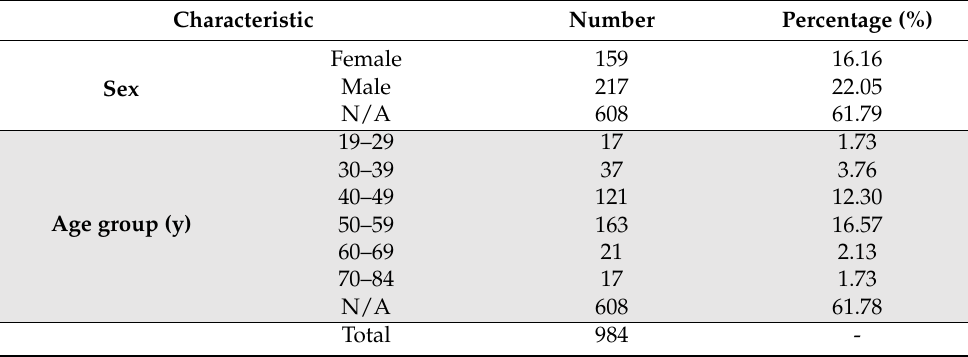
Table 1. Demographic distribution of the study population.